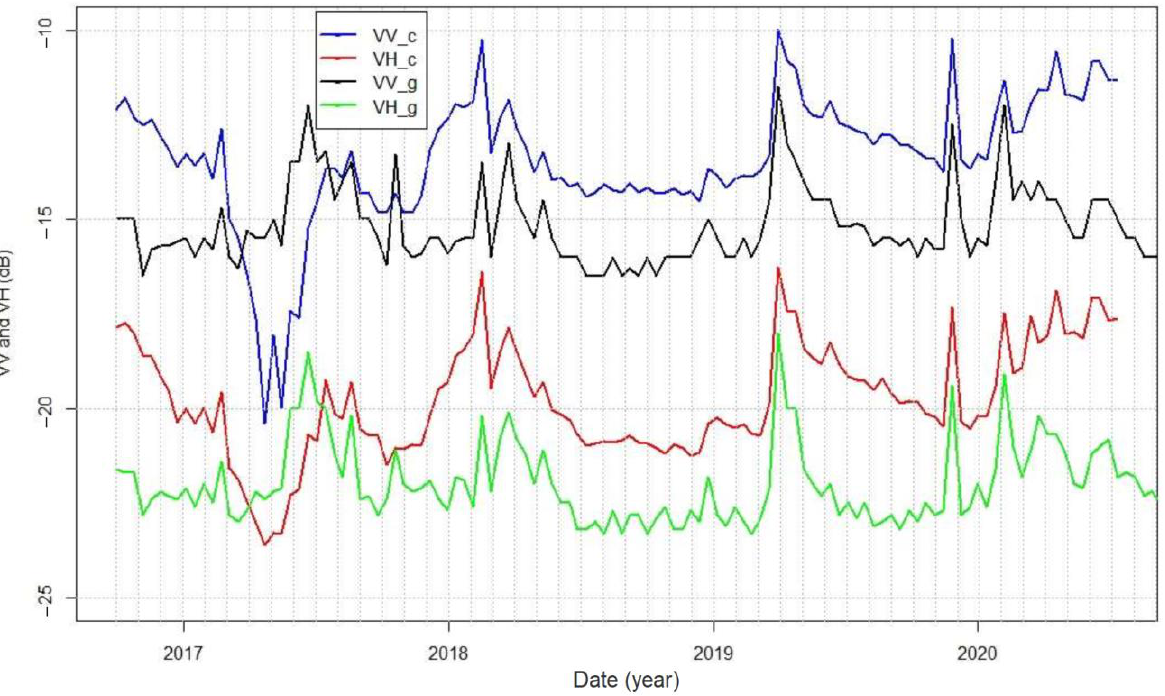
based on the intersection of the observed water elevation contour line over SAR images (blue and